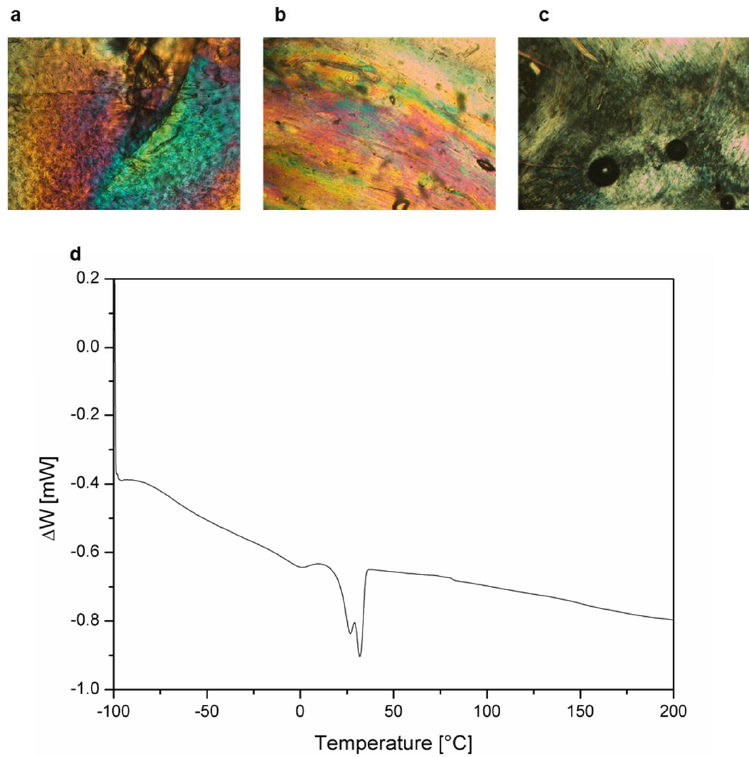
Figure 3. Polarised optical microscopy (POM) images of CP 36 ( a ) at 25 °C, ( b ) at 35 °C, ( c ) at 59 °C and ( d ) Differential scanning calorimetry (DSC) curve for the second heating scan.